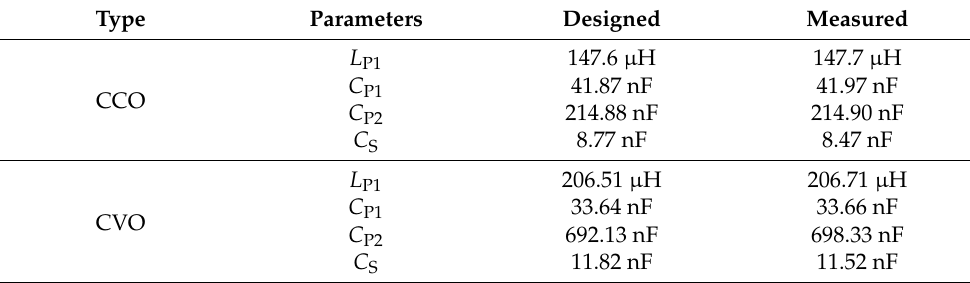
( b ) Figure 13. Waveforms of the CVO-type LCC-S compensation topology in Case C: ( a ) R O = 100 Ω , k = 0.5; ( b ) R O = 100 Ω , k = 0.25.